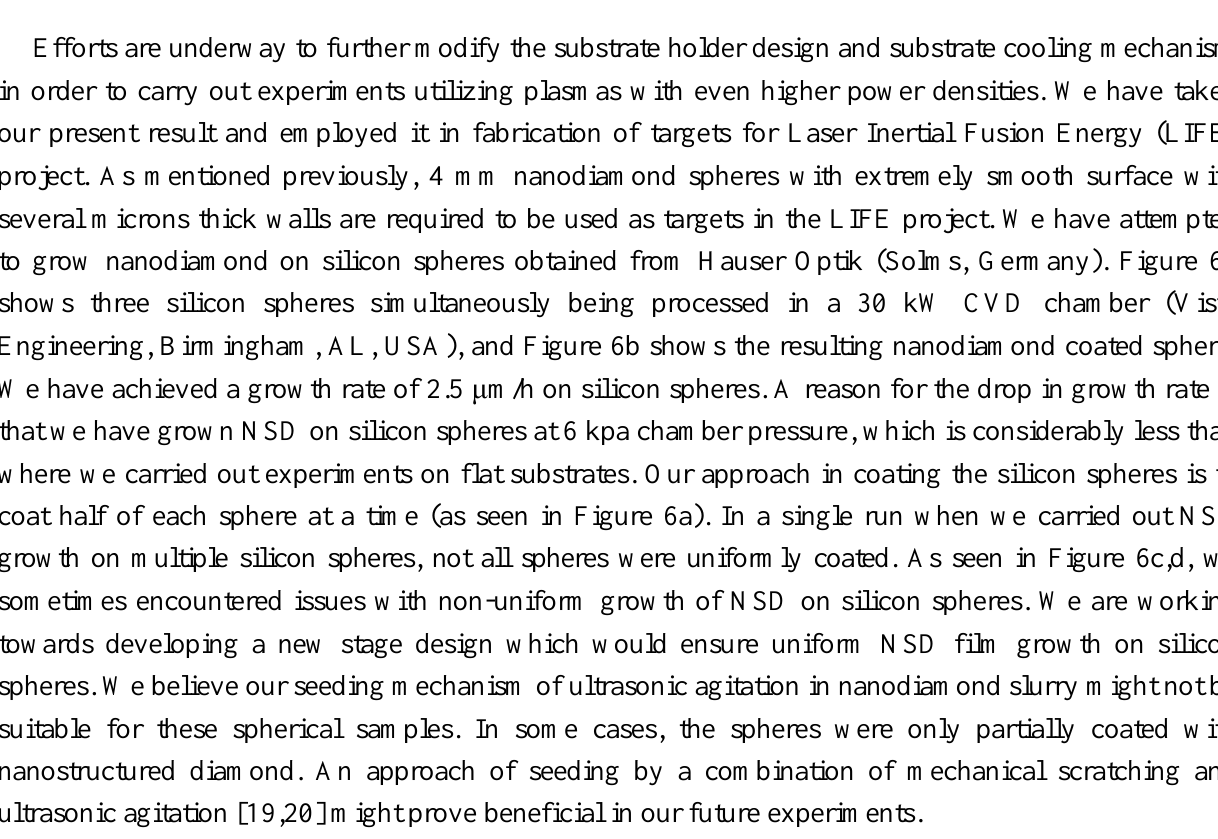
, 88 sccm of CH and 8.8 sccm 2 4